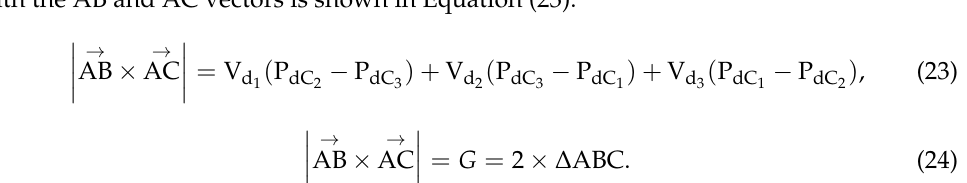
Figure 1. Plot of P dC versus V d for N-KZFS11, N-SF66, and N-PK52A glasses.